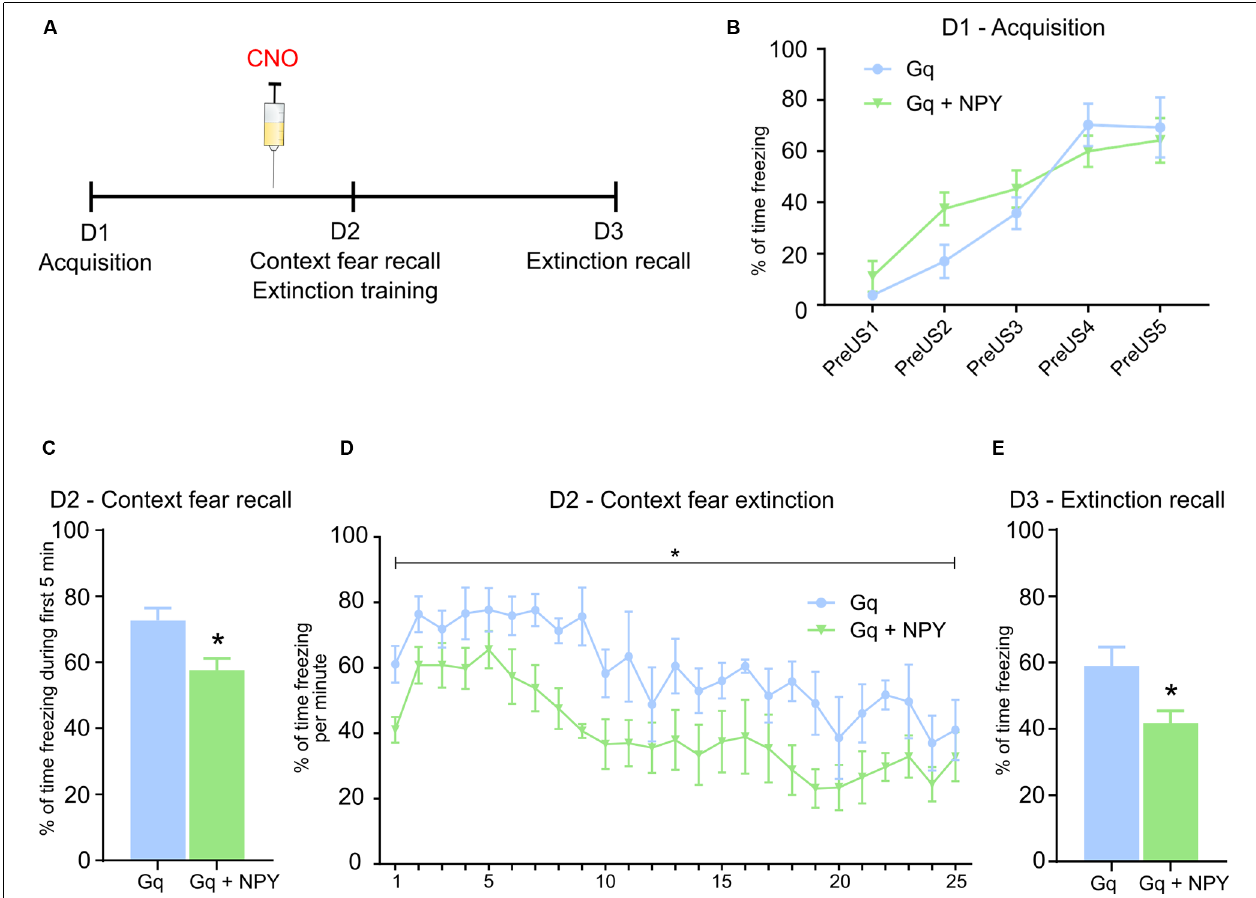
FIGURE 3 | NPY over-expression in GABAergic neurons of the dorsal dentate gyrus reduces context fear expression upon activation. (A) Foreground context fear protocol: On day 1 (D1), during fear acquisition mice received 5 US separated by a variable time interval. On day 2 (D2), mice were injected 30 min before the test with CNO (ip, 1 mg/kg). Fear testing and extinction training: On day 3 (D3), mice were placed again into the same context for 5 min to test for extinction recall in the absence of CNO injection. (B) No change in percentage of freezing measured during the 20 s period before each US (PreUS1–5) between Gq and Gq + NPY injected mice. (C) During testing of contextual fear recall following peripheral injection of CNO, Gq + NPY mice exhibited a lower percentage of freezing compared to Gq mice. (D) Similarly, Gq + NPY mice displayed a lower percentage of freezing during context fear extinction upon peripheral injection of CNO. (E) On D3, in the absence of peripheral CNO injection, Gq + NPY mice showed a lower percentage of freezing during 5 min of context fear recall. Data are presented as means ± SEM, * P < 0.05. Gq: n = 4, Gq + NPY: n = 5. Abbreviation: US, unconditioned